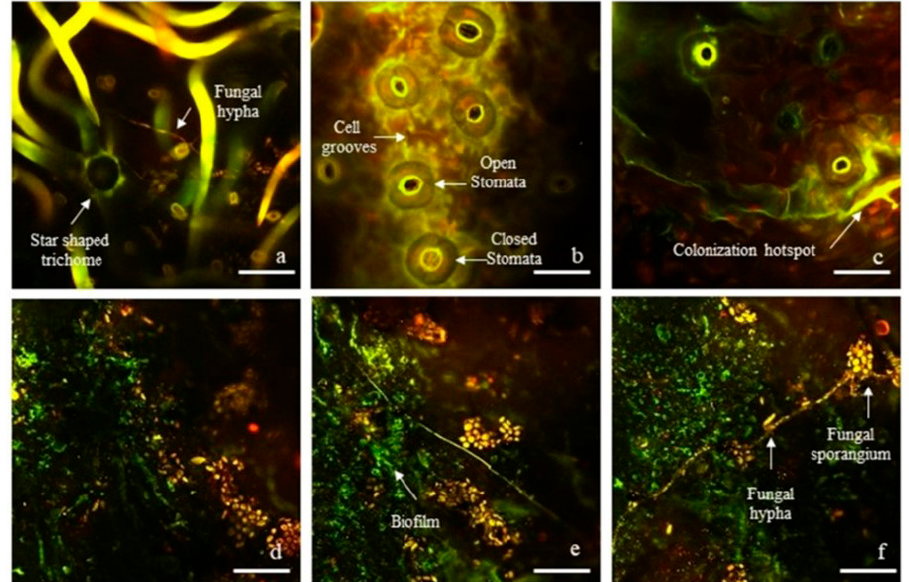
Figure 1. Panel showing phyllosphere microorganisms arrangements with regard to Q. ilex leaf functional traits (cuticle, stomata, and trichomes). Images have been obtained through the use of LIVE/DEAD™ BacLight™ Bacterial Viability Kit and two-photon excitation microscope (Ultima investigator 2-photon microscope—Bruker, MS, USA). Images ( a – c ) referred to abaxial leaves surfaces; images ( d – f ) referred to adaxial leaves surfaces. The images were obtained by merging the two emission filters, in green and red, to allow the visualization of live and dead (bacterial and fungal) cells, respectively, highlighted by the dyes used (Syto9 and propidium iodide). Scale bar = 20 µ m ( b – f ); Scale bar = 50 µ m ( a